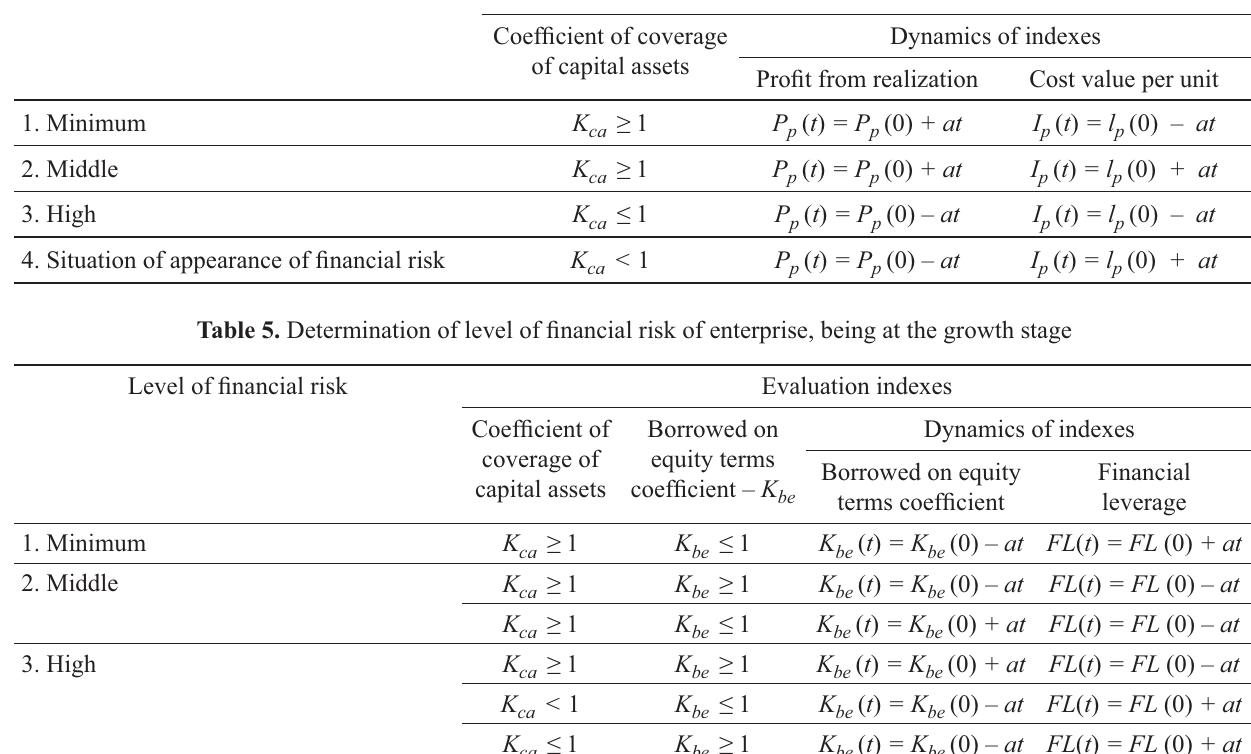
Table 4. Determination of level of fi nancial risk of enterprise, being at the introduction stage Level of fi nancial risk